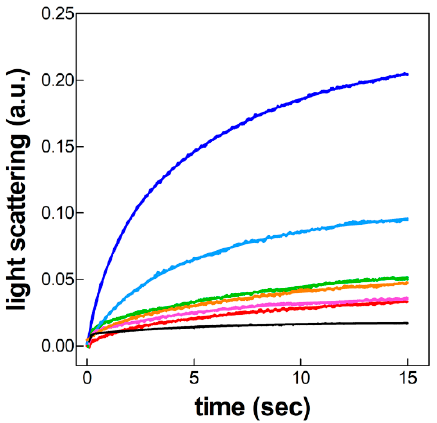
Figure 5. Kinetics of 50S subunits docking to 30S initiation complexes formed with different mRNAs. 30S initiation complexes, prepared by 30 min incubation at 15 °C using various mRNAs, were rapidly mixed in a stopped flow apparatus with a stoichiometric equivalent of 50S ribosome subunits and the real time change of the light scattering signal (expressed in arbitrary units in the ordinate) generated by subunits association was recorded. cspA (dark blue); cspD (red); A 1 A 2 D 3 (light blue); A 1 D 2 D 3 (green); D 1 A 2 A 3 (magenta); D 1 D 2 A 3 (orange). Each trace is the average of at least 15 different shots. The light scattering values detected at time = 0 were subtracted from each point of the traces. Further details are given in Materials and Methods.